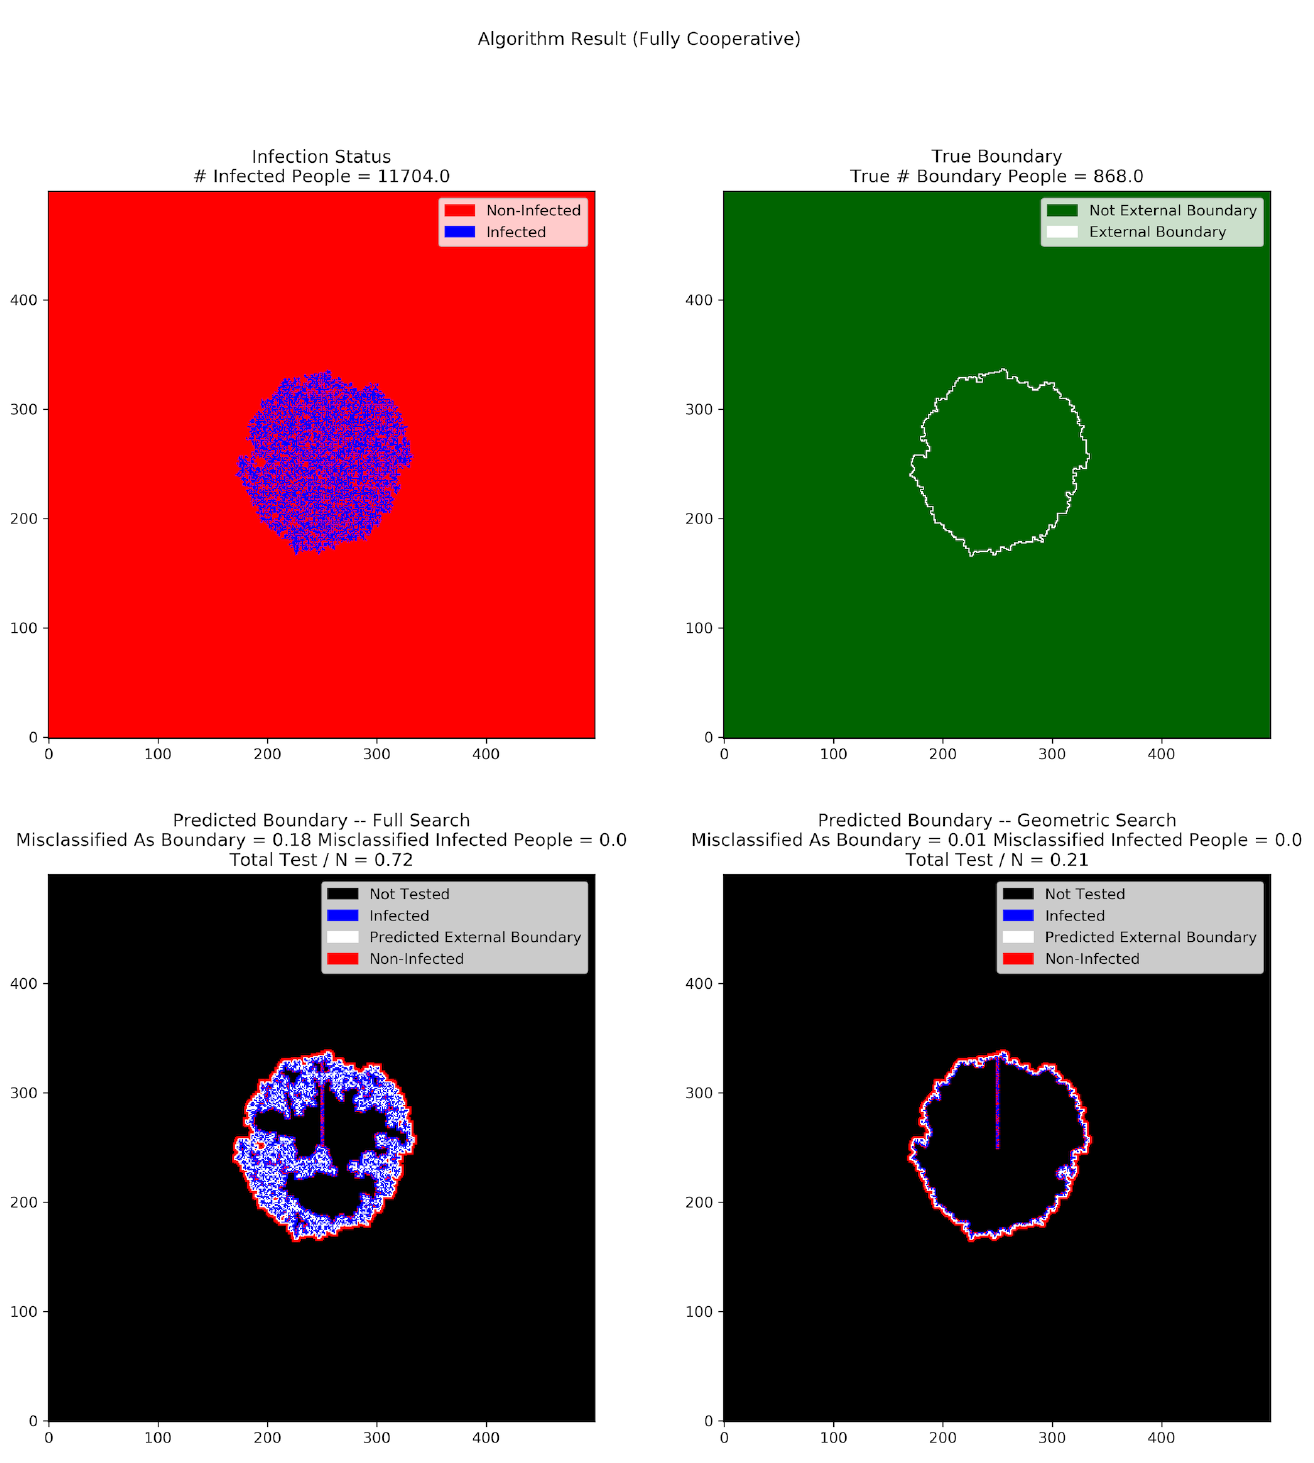
Figure 3. Population = 250,000 Non-cooperative Rate = 0. Duration = 200 Infection Probability = 0.1. N: number of people inside and containing the external